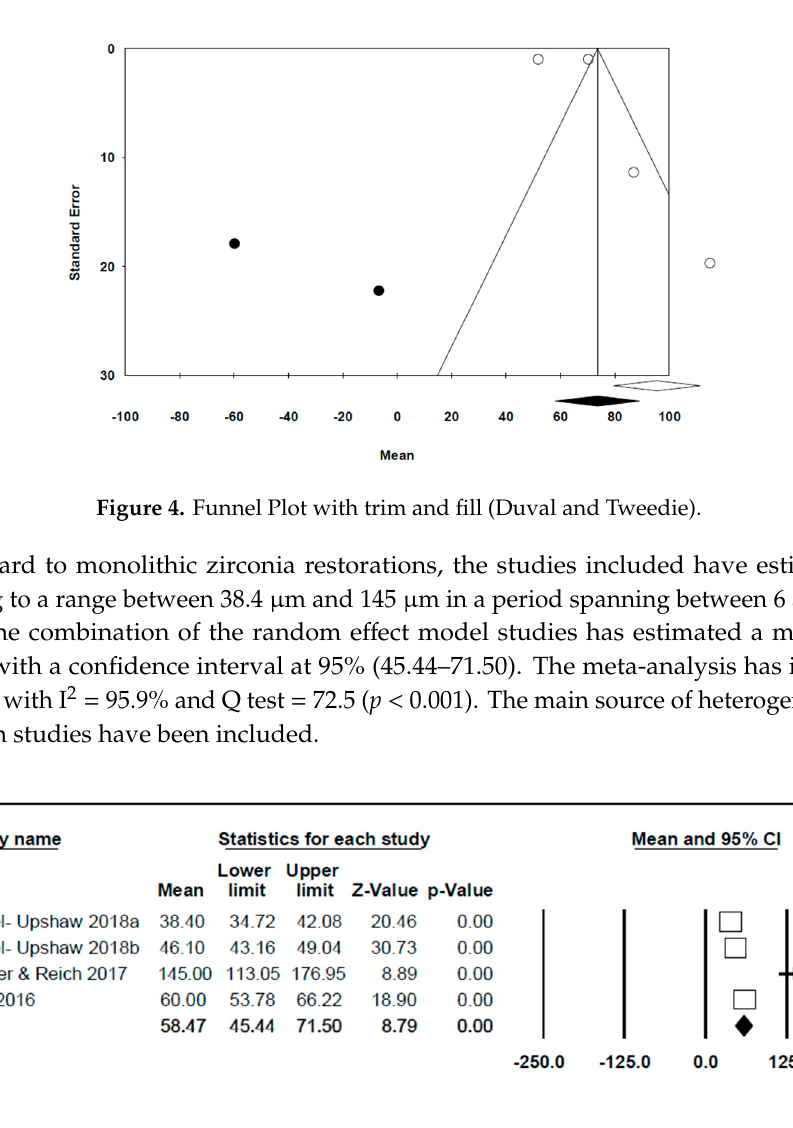
Figure 6. Graph depicting meta-regression for wear in monolithic zirconia vs. time. The funnel plot (Figure 7) depicts a distribution for the results of the studies. By using the trim and fill method, the new estimation of effect was not different to the original measurement (58.47 µm). By using Egger’s Test, we obtained a beta coefficient for the intercept: 7.07, with a CI at 95%, ranging from − 7.06 to 21.2 ( p = 0.164). The mean is situated between − 5.63 and 14.73, indicating a low bias risk.